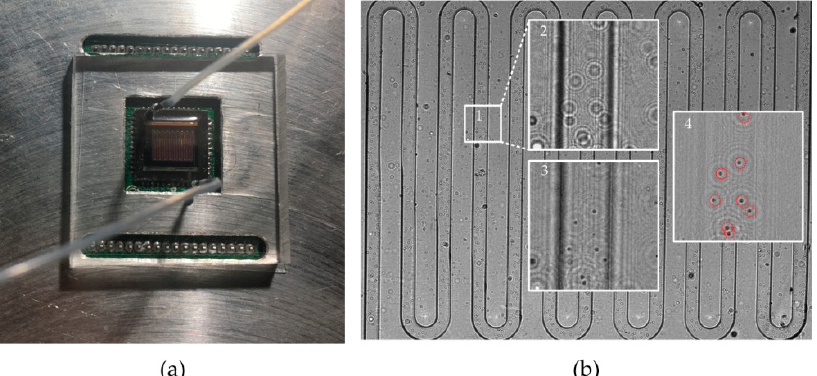
Figure 2. The proposed flow cytometer: ( a ) The flow cytometer system; ( b ) the holograms of the microfluidic chip captured by the system. Box 2 is an amplificatory image of box 1, and box 3 is a diffractive reconstruction image of box 2. Box 4 is the image of box 3 with the background removed, where the red circles mark the cells.